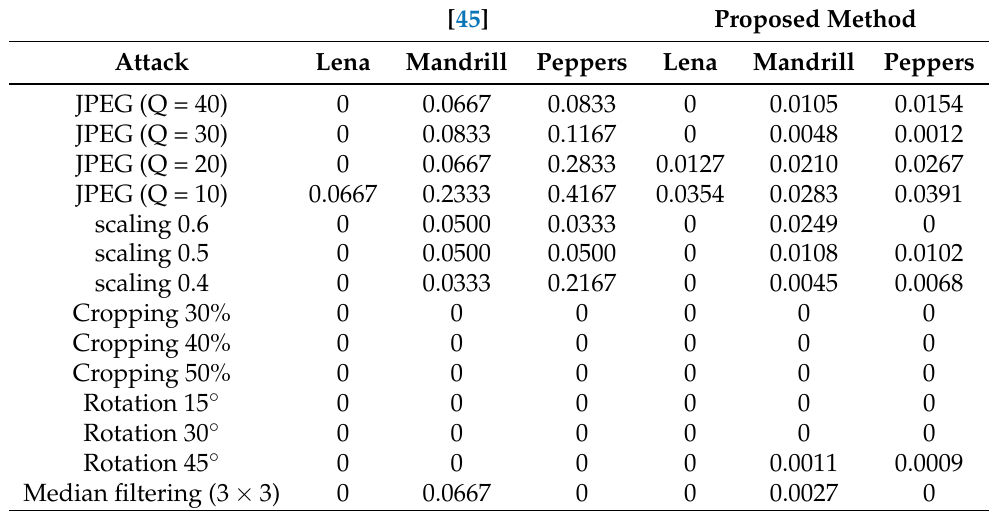
Table A4. Robustness comparison with [45] measured in terms of BER for Lena, Baboon and Peppers images.